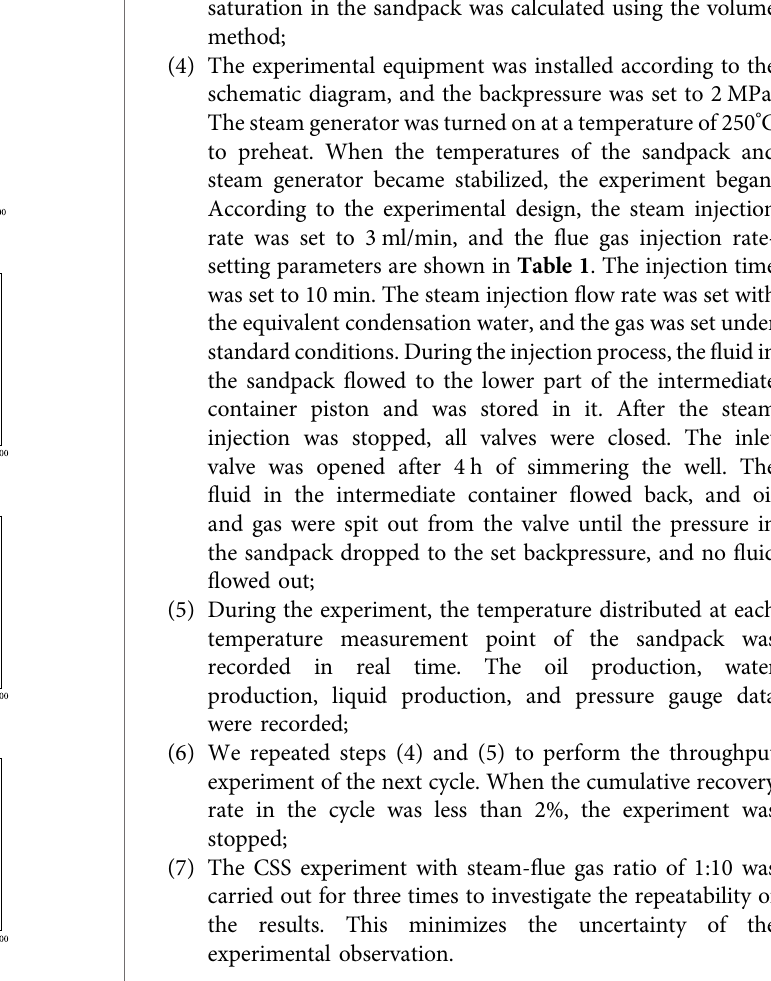
Frontiers in Energy Research |